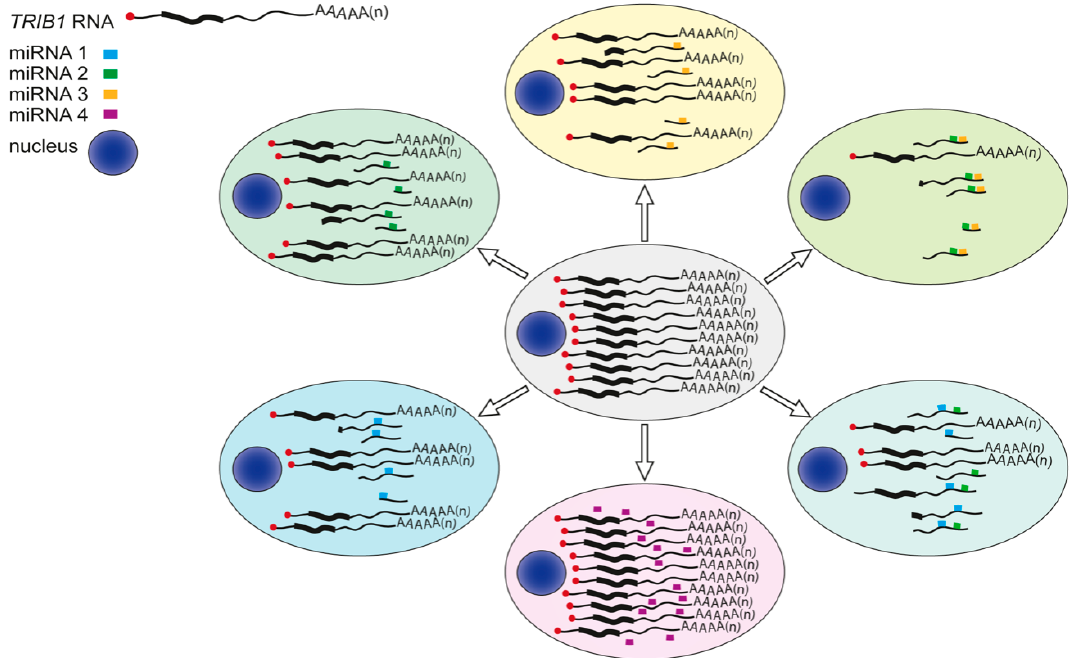
Figure 6. Cell-specific microRNA targeting of capped, polyadenylated TRIB1 transcripts. Newly-synthesised, capped, polyadenylated TRIB1 transcripts are subjected to microRNA (miRNA)-mediated de-adenylation and translational repres- sion. Newly exported TRIB1 transcript (centre cell) fate will vary on cell-type, physiological cues and miRNA compliment (coloured cells). The relatively long (~2000 nucleotides) 3 ′ untranslated region of the TRIB1 -201 transcript contains potential binding sites for 1237 different miRNA [56]. Binding of miRNAs to closely-spaced sites (2 o’clock position) may facilitate cooperative behaviour leading to more de-adenylation and translational repression of TRIB1 -201 transcripts than that achieved through combinational binding of miRNAs to target sites separated by >~60 nucleotides [57] (4 o’clock position).